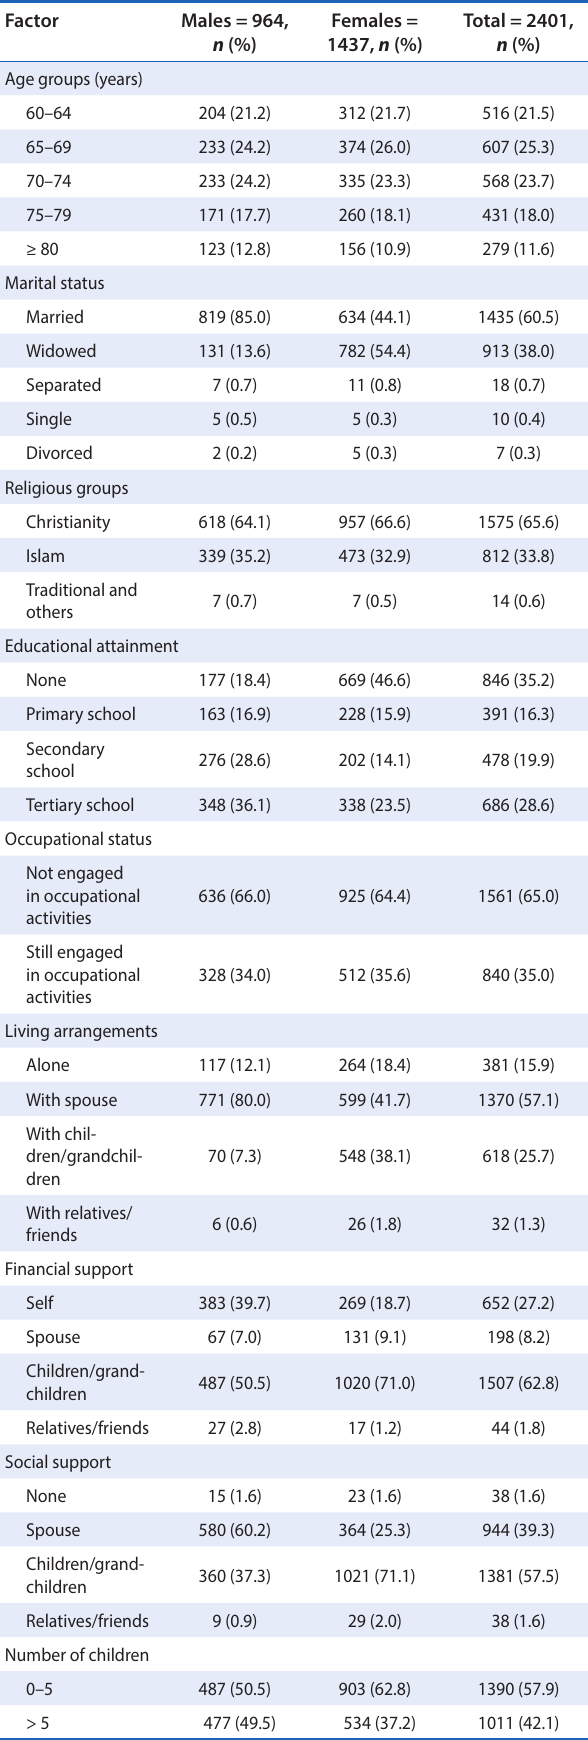
Table 1: Socio-demographic